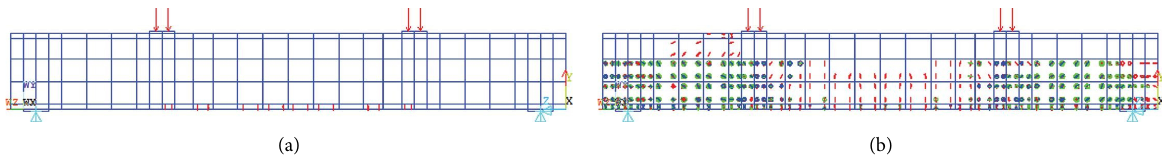
Figure 17: When the number of tensile steel bars was increased, the beams began to break and sufer damage as a result: (a) cracks begin to appear in the beam ( P crack � 9kN), 3 ϕ 22; (b) damage to the beam begins to appear ( P max � 135kN), 3 ϕ 22.